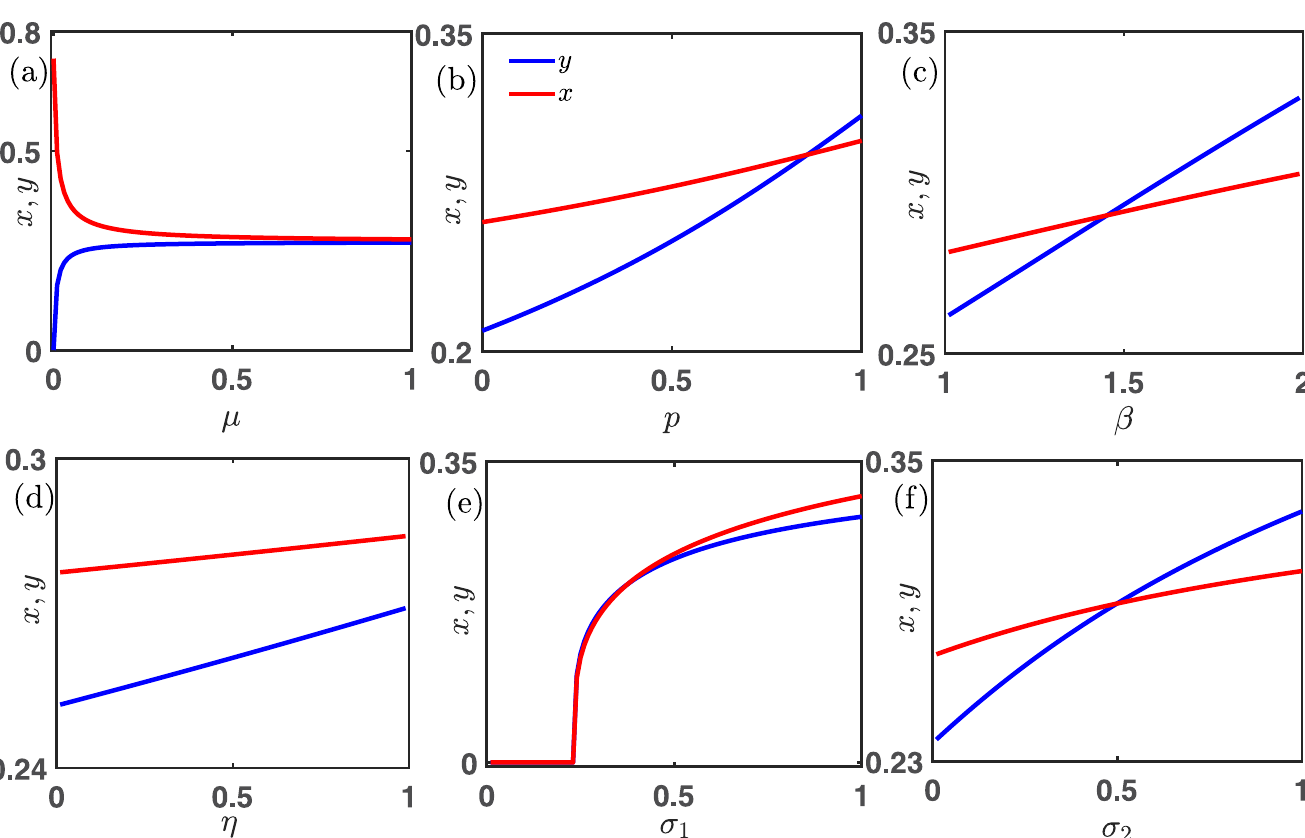
Fig 9. Effects of various parameters in spreading of cooperative behavior. Subfigure (a) reveals two contrasting scenarios, where the cooperators decrease with the increment of the mutation rate μ . However, the defectors’ fraction gradually increases with increasing μ . In the absence of mutation (i.e., for μ = 0), all defectors are extinct as the parameters values chosen to produce this subfigure is ξ = 0.25, β = 1.1, η = 0.85, p = 0.65, σ 1 = 0.75 and σ 2 = 0.25. Thus, the free space induced benefit towards cooperator σ 1 is greater than that of defector σ 2 . Subfigure (b) shows that both species’ densities gradually increase with the probability p of playing the PD game. As the probability of playing the PD game increases, the increment of the fraction of defectors (blue line) gets over in margin with respect to the fraction of the cooperators (red line) after p = 0.85 depending on other parameters’ values. This fact is obvious from the view that a higher possibility of playing the PD game gets a more beneficial ambiance for defectors. Subfigure (c) indicates the same phenomena as the value of the temptation payoff parameter β increases, both the fractions escalate. Whereas at β = 1.45, both these fractions get the same value. After that value of β , the value of the fraction of defector (blue line) becomes more than that of the cooperators (red line). Subfigure (d) also highlights the increment of both the fractions as the punishment payoff parameter η increases. But up to the highest received payoff value of η , the value of the fraction of defectors can never exceed the cooperators’ fraction because the free space provides more benefit to the cooperators than the defectors. Subfigure (e) demonstrates that when σ 1 2 [0, 0.25], both these fractions are extinct, as the mortality rate ξ has more value than these free space-induced benefits. But as the value of σ 1 increases, the cooperator gets more advantages than defectors. Subfigure (f) shows that both the fractions increase with the enhancement of σ 2 . Up to σ 2 = 0.5, the cooperators’ density acquires more value than y , as the value of σ 1 = 0.75 is taken sufficiently high. After σ 2 = 0.5, y becomes higher than x . All the subfigures are drawn by iterating the system (8) with 20 × 10 5 times with fixed integrating step length δ t = 0.01 and fixed initial condition ( x 0 , y 0 ) = (0.35, 0.35). The last point at 20 × 10 5 iteration is collected to identify the asymptotic state of the proposed model. Other parameters are kept fixed at ξ = 0.25, β = 1.1, μ = 0.5, p = 0.65, η = 0.85, σ 1 = 0.75 and σ 2 = 0.25, unless they are